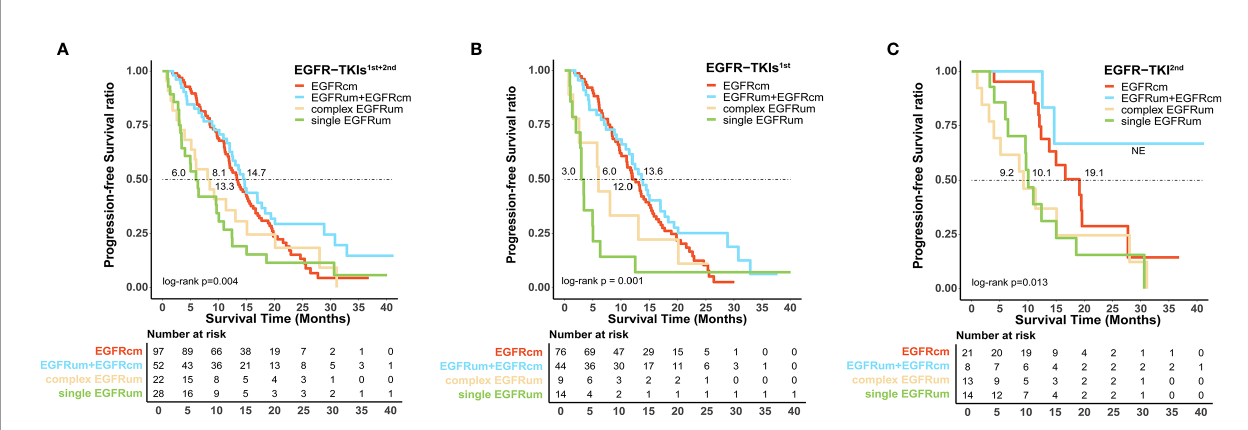
FIGURE 2 | Patients harboring uncommon EGFR mutations with different mutation patterns exhibited diverse survival outcomes to the fi rst-line therapy of EGFR - TKIs. Kaplan – Meier curves for progression-free survival in patients with different mutation patterns (A) in the fi rst and second generations of EGFR -TKIs cohort; (B) in the fi rst generation EGFR -TKIs cohort; and (C) in the second generation EGFR -TKI cohort. EGFR cm, common EGFR mutations; EGFR um, uncommon EGFR